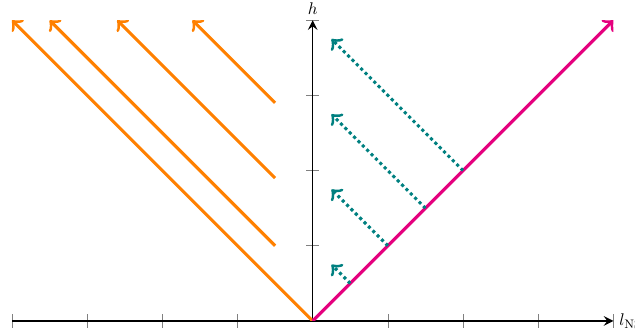
Figure 1 . The orange solid arrows and the magenta line on the unitarity bound indicate directions of Cardy-like growth (3.27). The torquise dotted arrows Hagedorn growth (3.26), which is only valid for l NS >